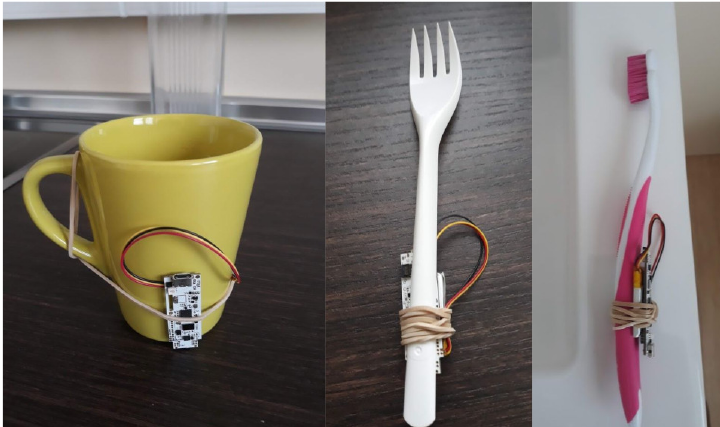
Figure 1. Prototyping of smart objects (a cup, a toothbrush, and a fork), whose orientation and movement data are collected and sent in real time by an inertial miniature board (The